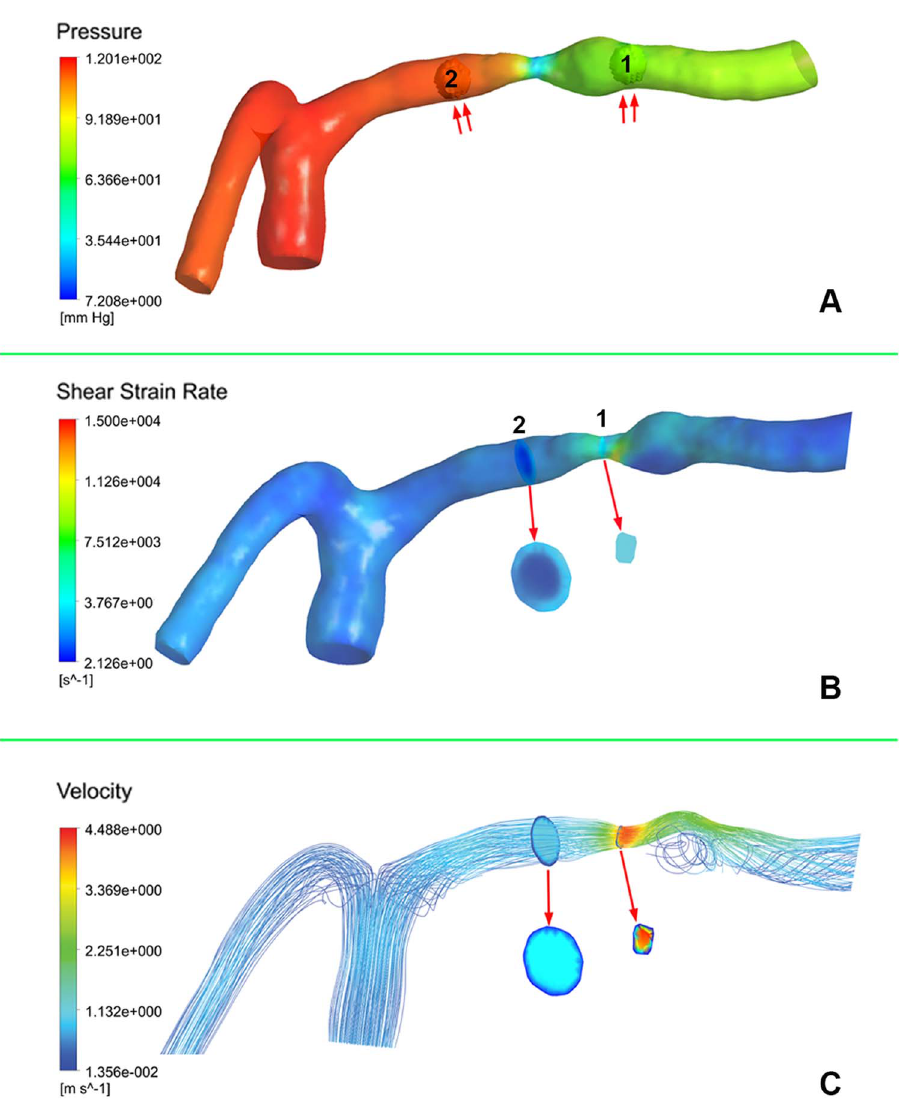
Figure 1. Evaluation of computational fluid dynamics model of an atherosclerotic lesion of left middle cerebral artery. A: Post- and pre-stenotic pressures were measured using spherical volumes-of-interest (VOI, double arrows) at the first anatomically normal diameters distal (VOI 1) and proximal (VOI 2) to the lesion, respectively. The pressure ratio was calculated by dividing the mean pressure at VOI 1 by the mean pressure at VOI 2. B: Shear strain rates (SSR) were respectively measured at the stenotic throat (cut-plane 1) and at the first anatomically normal diameter (cut- plane 2) proximal to the lesion, by using cut-planes perpendicular to the direction of blood flow (arrow). The SSR ratio was calculated by dividing the SSR averaged over cut-plane 1 by the SSR averaged over cut-plane 2. C: Velocities were similarly measured (arrow) as with the SSRs, and the velocity ratio was similarly calculated as with the SSR ratio.